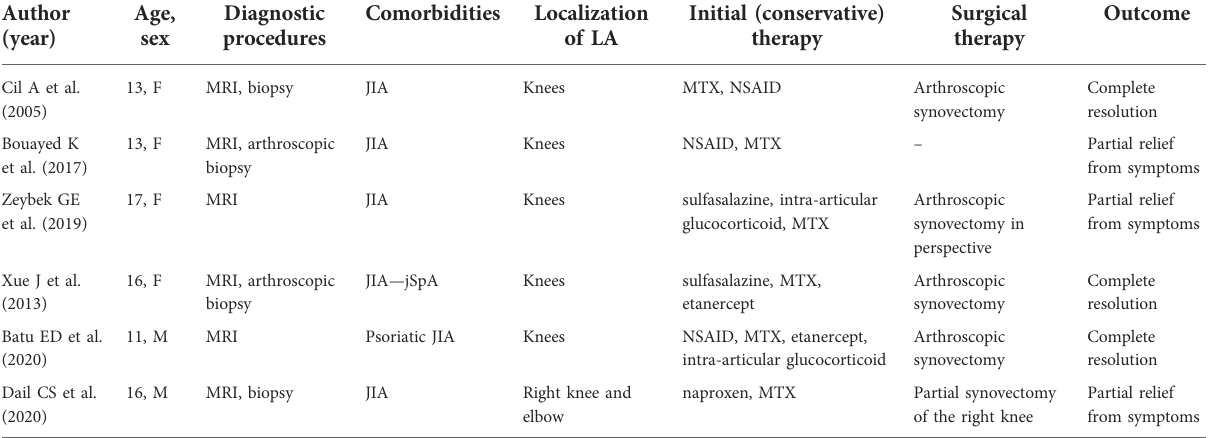
TABLE 1 Summary of lipoma arborescens reported cases in children with juvenile idiopathic